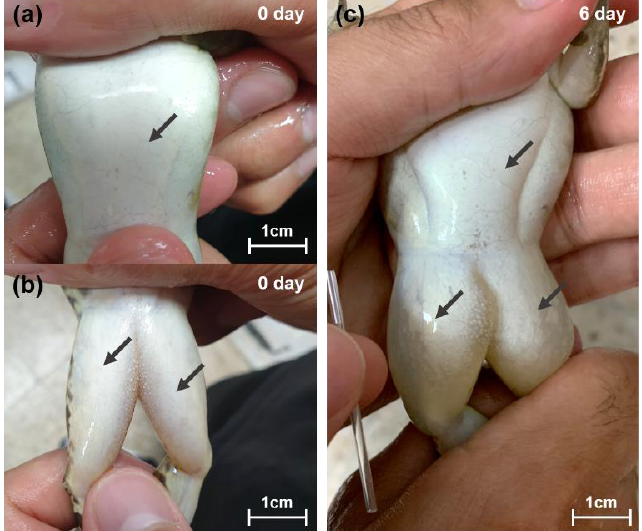
Figure 5. Ventral and femoral image of a frog in the severe condition: ( a ) ventral image of frog on 0 days (before salinity exposure), ( b ) femoral image of frog on 0 days (before salinity exposure), ( c ) ventral and femoral image of frog on 6 days (after salinity exposure). The individual in the image is the same frog, and after exposure to salinity, the skin in the ventral and femoral area is swollen and the ascites are full.